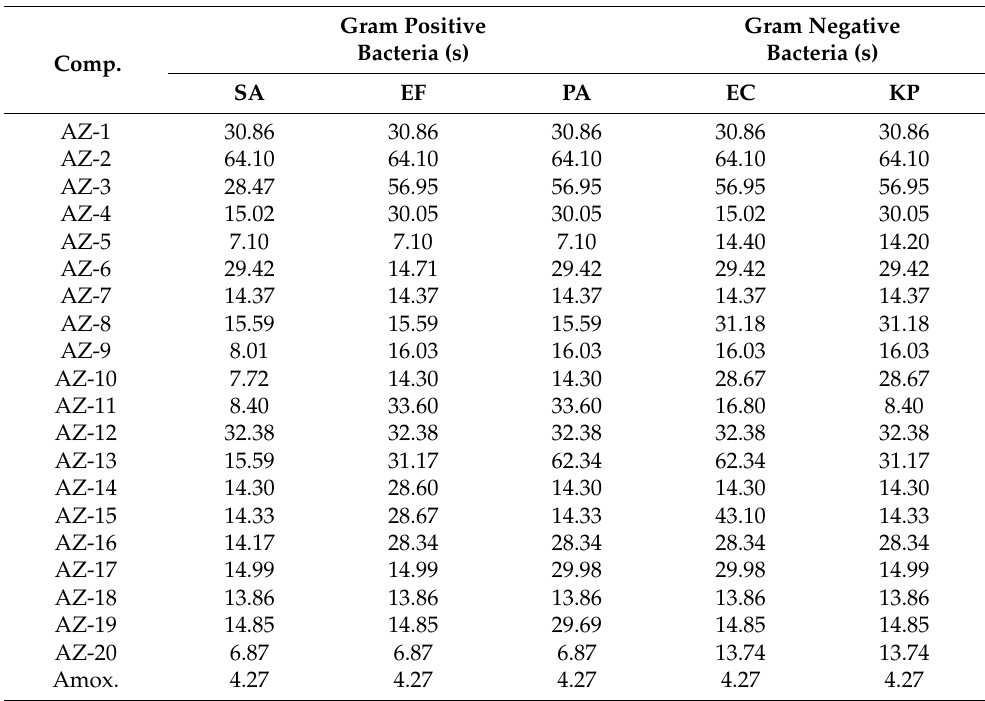
Table 3. Minimum bactericidal concentration ( µ M) screening of azetidin-2-one derivatives of 1,3,4- oxadiazole/thiadiazole